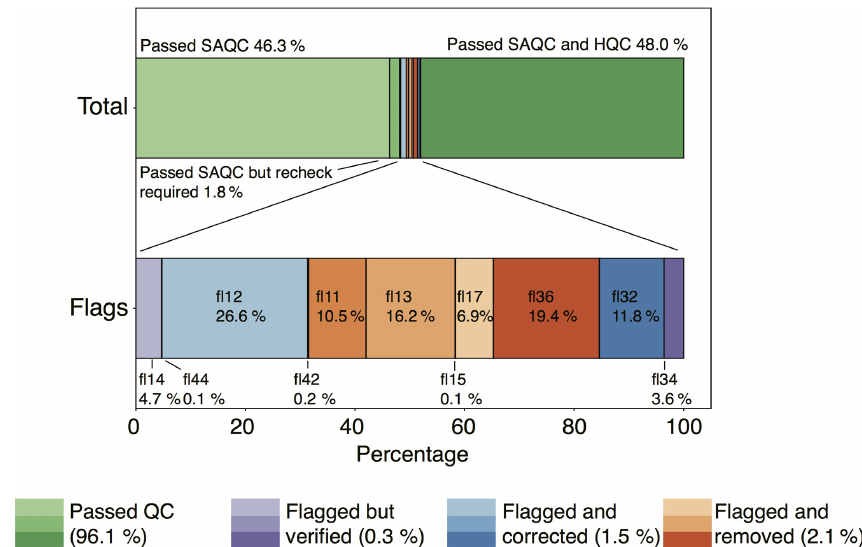
Figure 12. The percentage distribution of quality control flags in the dataset. Values that have passed QC are represented in green (QC flags fl10, fl40 and fl30); values that were flagged but verified as correct are shown in purple (fl14, fl44 and fl34); values that were flagged but corrected are shown in blue (fl12, fl42 and fl32); and values that were flagged and removed are shown in orange (fl11, fl13, fl15, fl17 and fl36). The darkness of the colours indicates the level of QC applied for each flag. Lighter colours represent values that were only subjected to semi-automatic quality control (SAQC, fl codes that begin with 1), darker colours indicate values subjected to both SAQC and spatial HQC procedures (fl codes that begin with 3), and the colours in the middle represent the small number of values that may need to be rechecked (fl codes that begin with 4). See Table 4 for additional flag